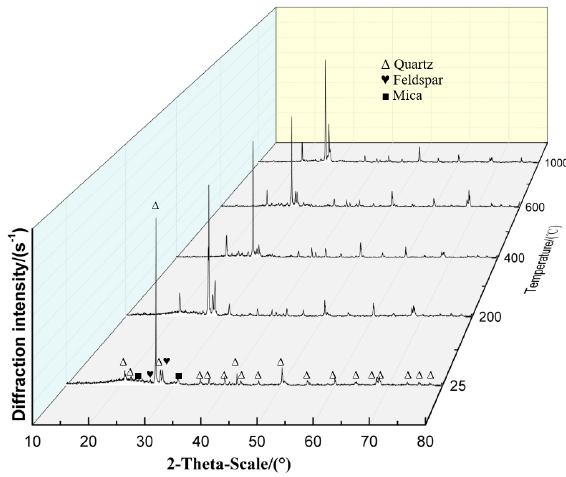
Figure 8. XRD spectra of sandstone at different temperatures.